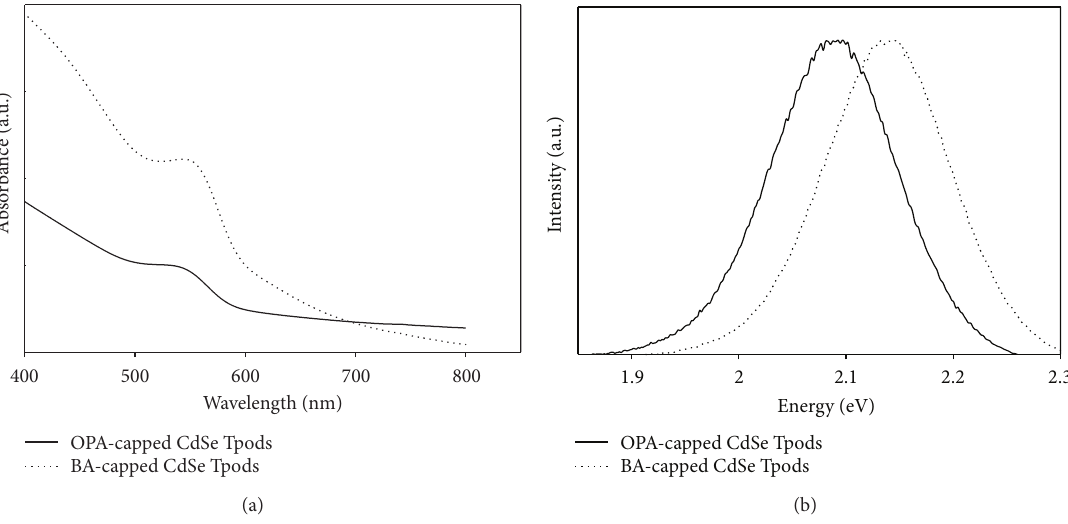
Figure 5: (a) Absorption and (b) photoluminescence spectra of CdSe tetrapods capped with OPA and BA